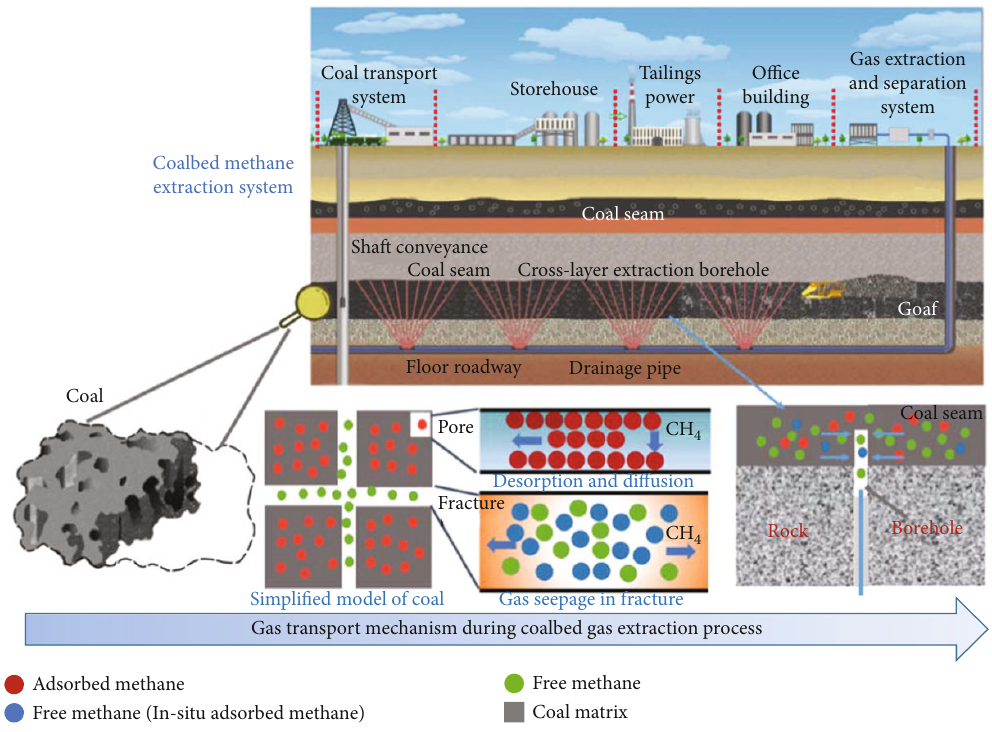
Figure 2: Gas transport mechanism during coalbed gas extraction process